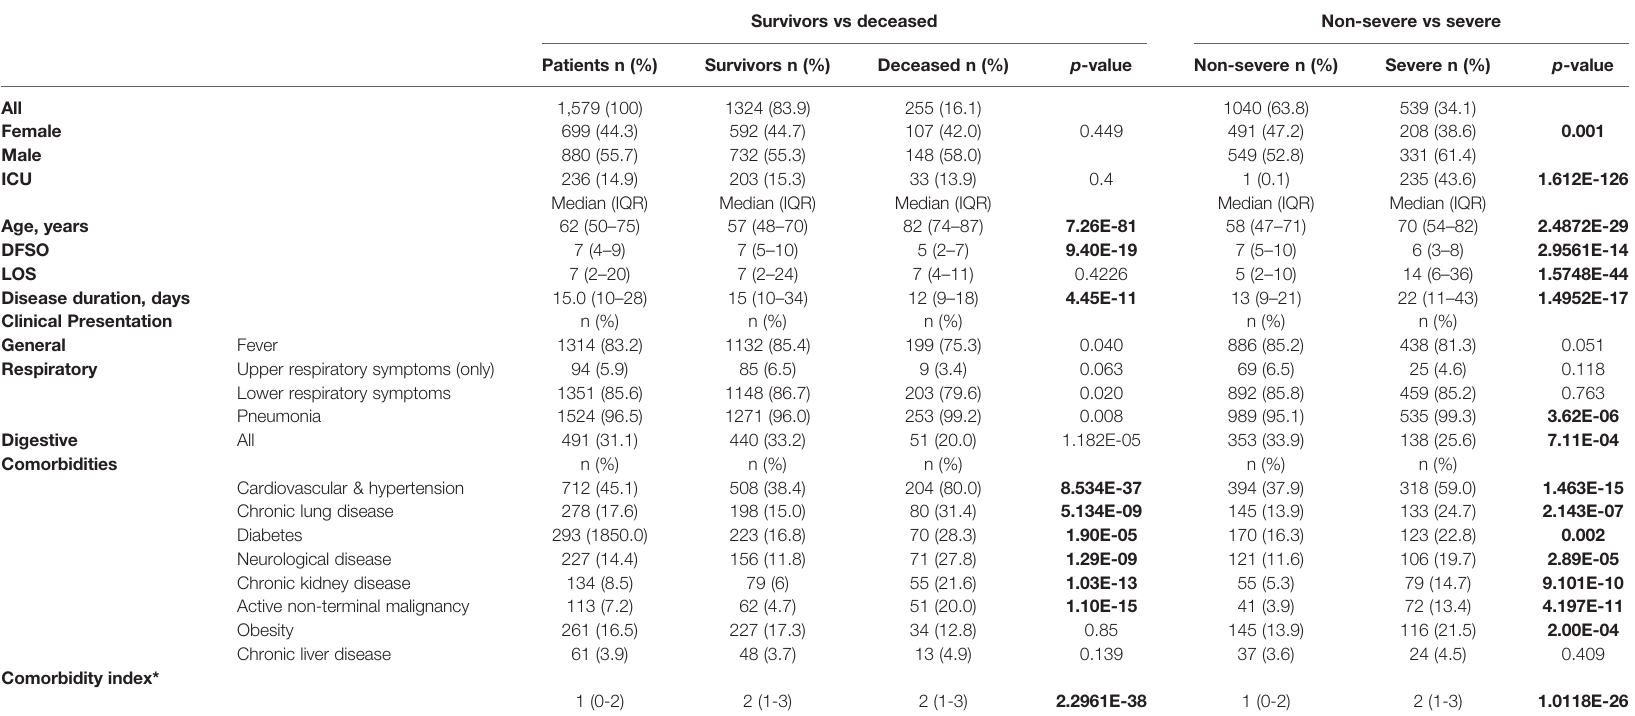
TABLE 1 | Summary of the clinical and demographic features of HUVH cohort vs